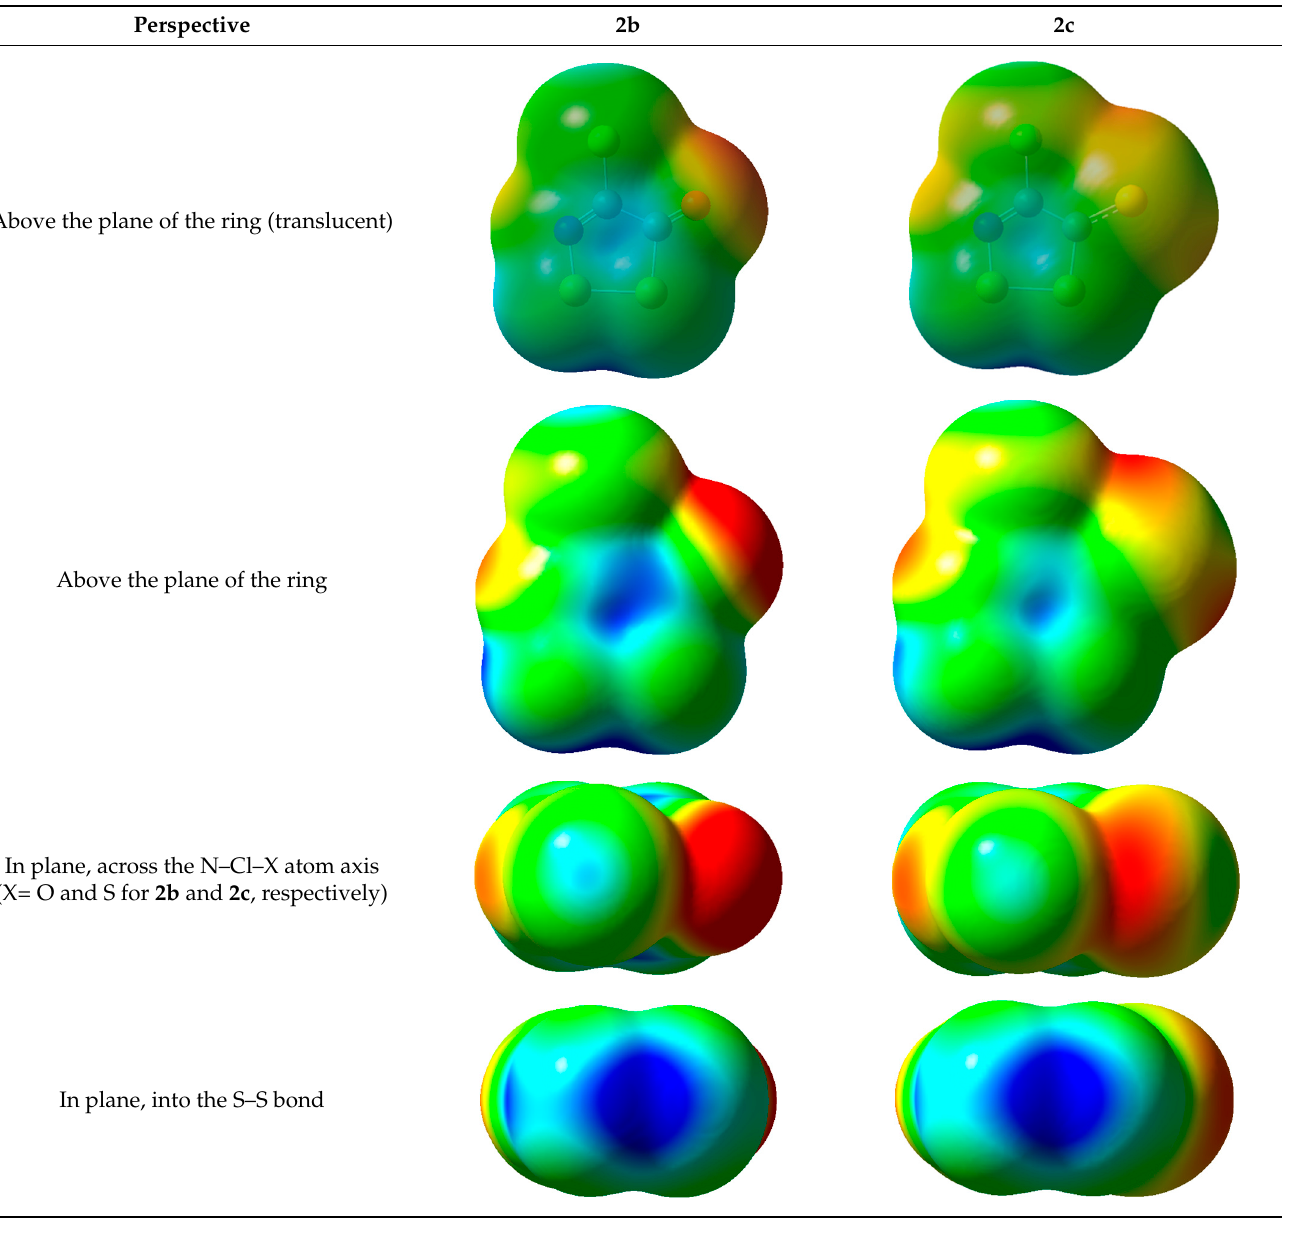
Table 2. B3LYP/def2-TZVPD potential energy maps (MEP) of the dithiazolone 2b and of the thione 2c ; the isovalue for both surfaces is 0.001.